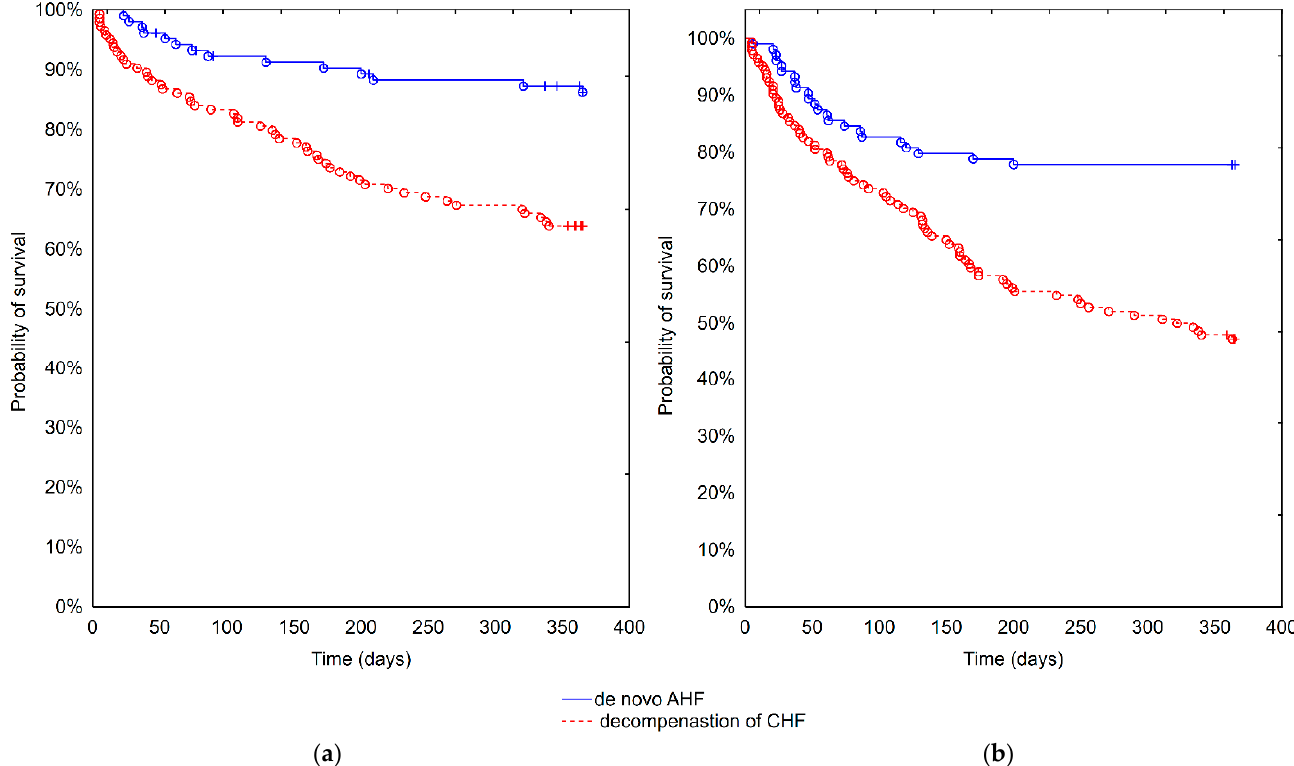
Figure 1. Kaplan–Meier curves comparing de novo AHF and ADHF. ( a ) Death. Log-rank p < 0.001. ( b ) Death or heart failure rehospitalization. Log-rank p < 0.001.